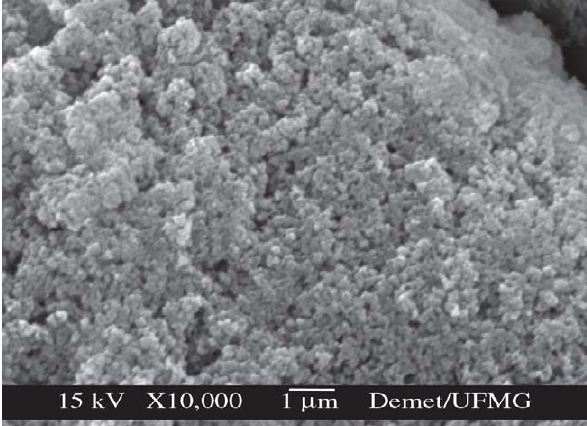
Figure 1. SEM micrograph of sample A1 of synthesized HA pow- der before thermal treatment.